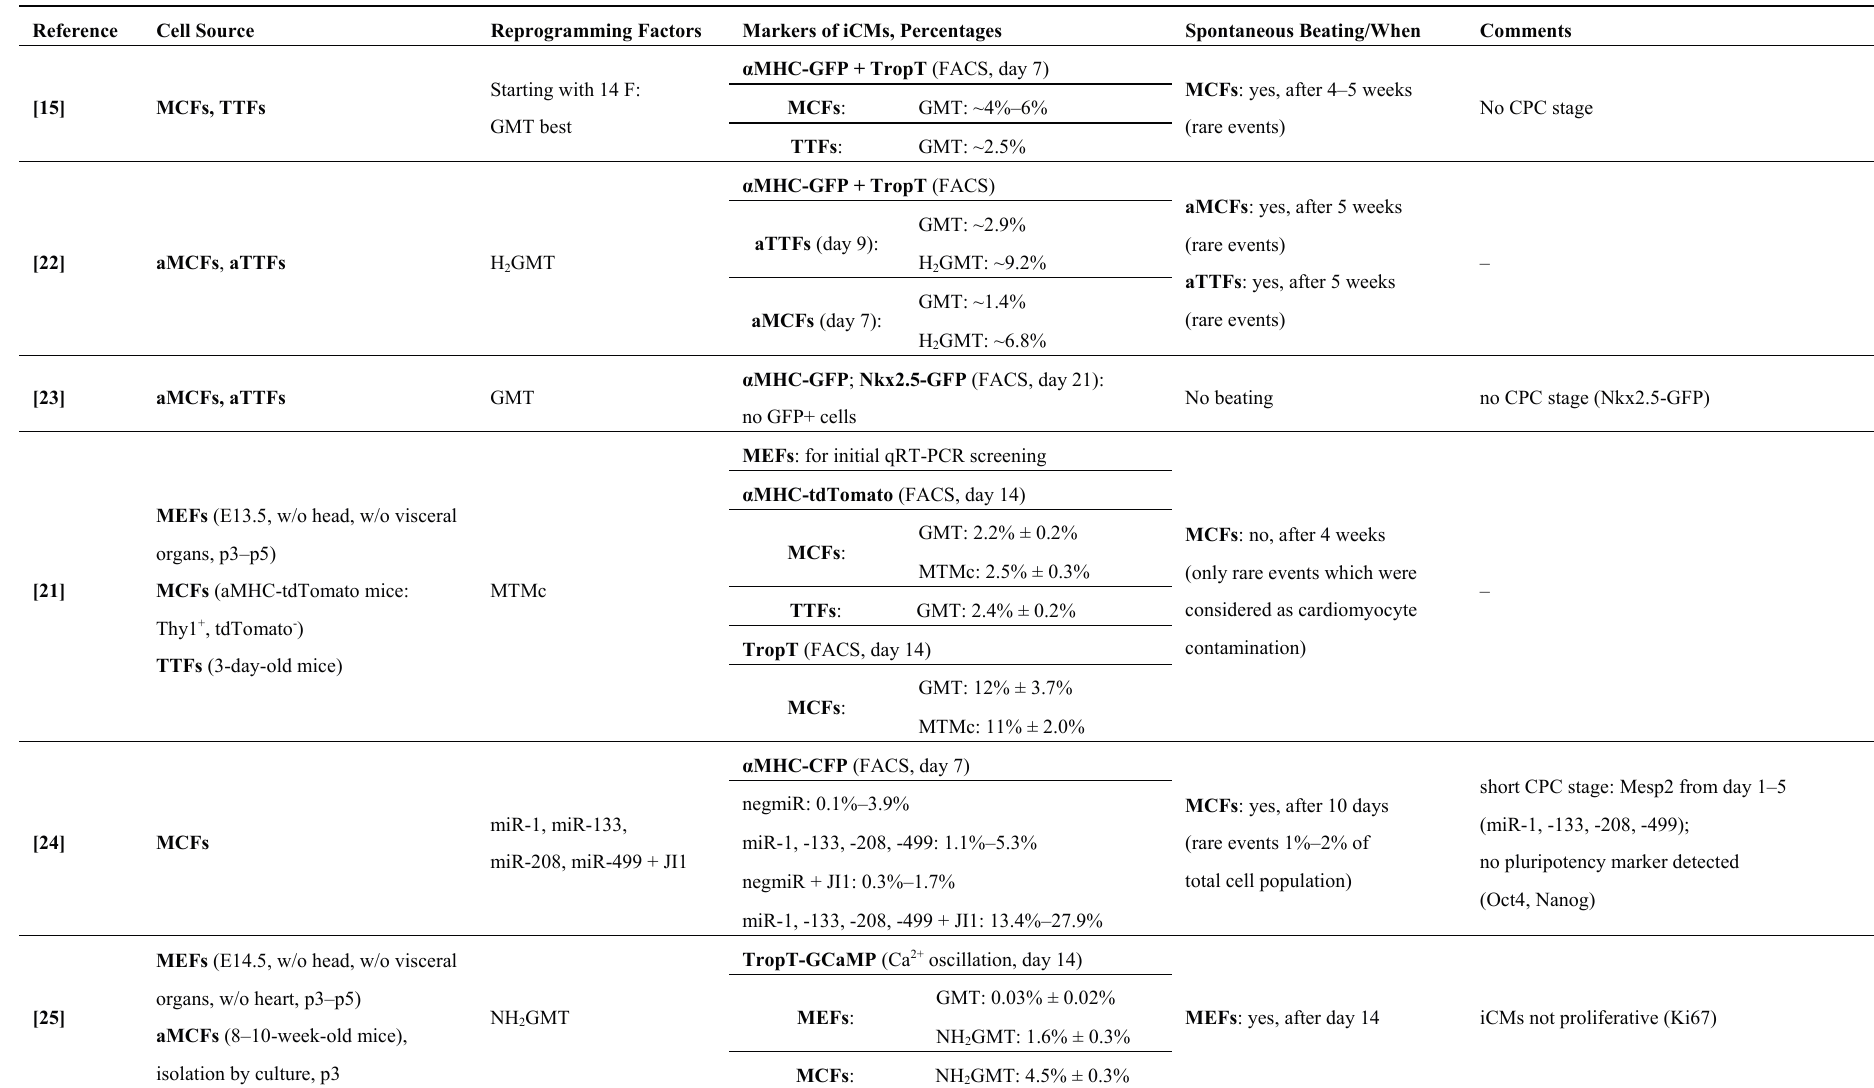
Table 1. Direct cardiac reprogramming in vitro